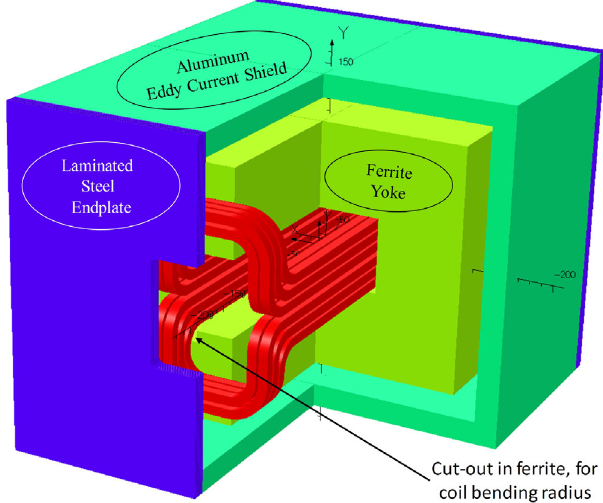
FIG. 3. Geometry of MedAustron kicker magnet, which served as a reference design for the TRIUMF kicker magnet. The overall length of the MedAustron magnet, including end plates, is ∼ 0 . 4